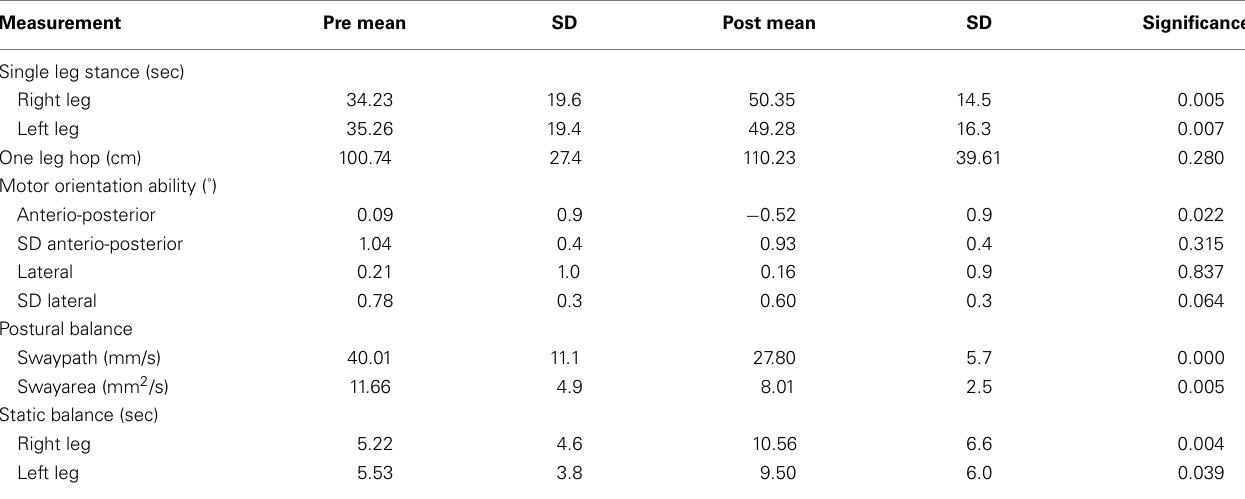
Table 2 | Outcome measurements in study